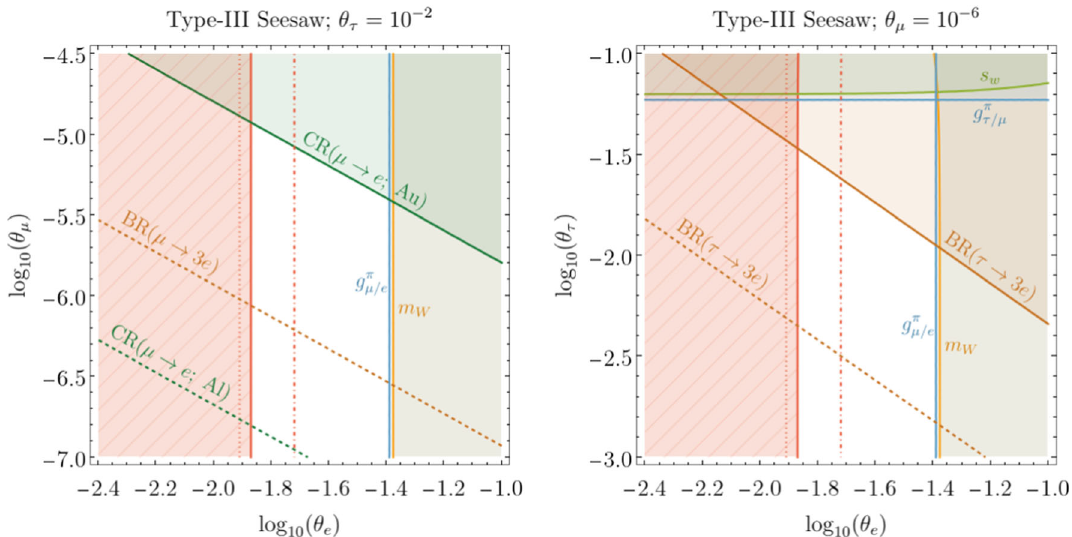
Fig. 7 Plots zoomed in on the viable parameter regions in the Type-III Seesaw model. Only the most constraining observables are depicted. The red-ruled regions indicate | (cid:8)σ/σ | < 0 . 5% at